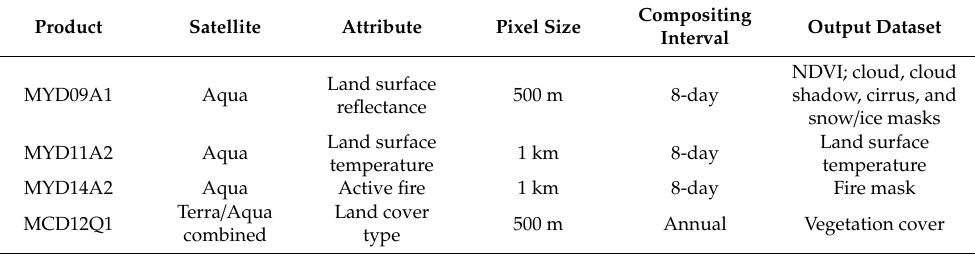
Table 1. MODIS datasets used for developing observed temperature di ff erence ( dT